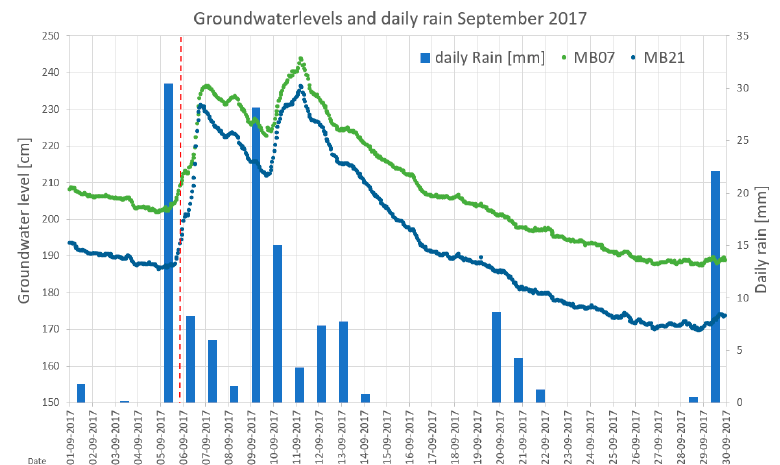
Figure 11. Response in groundwater level (cm) in the monitoring well MB07 (green line) and MB21 (blue line). The red dashed line marks the day of the full-scale infiltration test. Precipitation data from Florida metrological station in the center of Bergen, ca. 1.5 km from Bryggen. Data from Norwegian Metrological Institute @ eKlima.no [33].